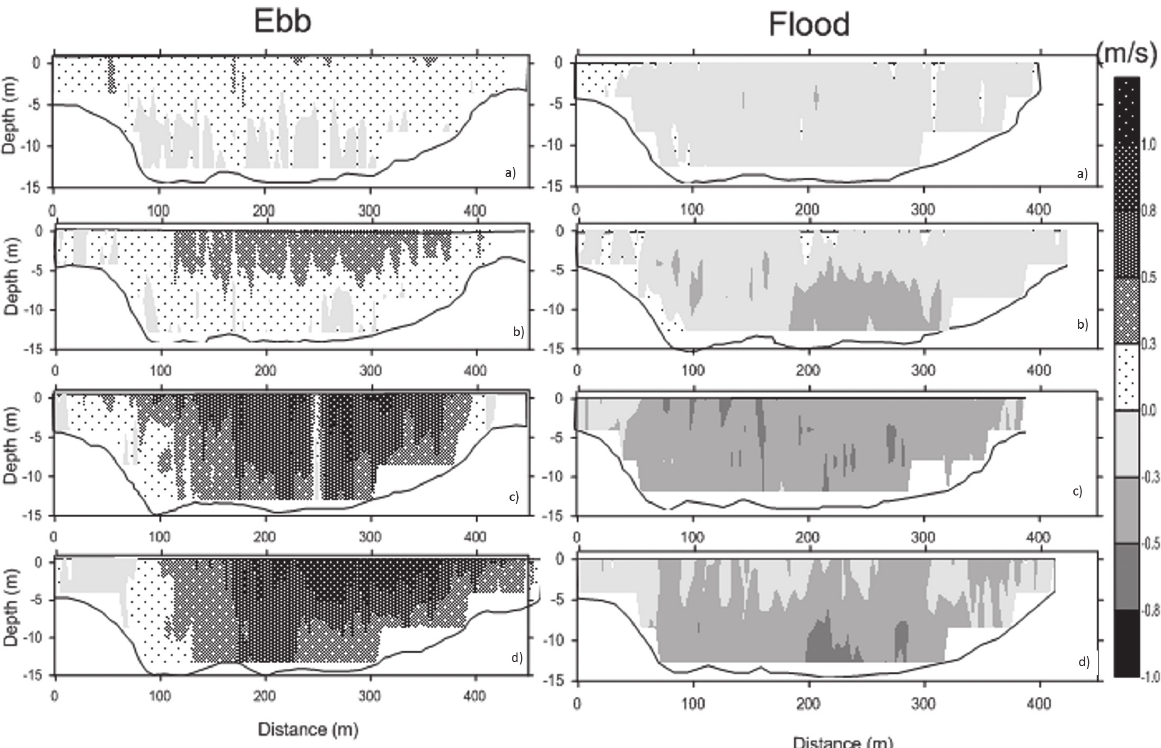
Figure 6 - Mean values for longitudinal velocity (m/s) along the channel cross section, during ebb and flood tides. a) QS – neap cycle during the dry season - 09/15/2010; b) SS- spring cycle during the dry season - 11/29/2010; c) QC – neap cycle during the rainy season - 09/22/2010 and d) SC – spring cycle during the rainy season -